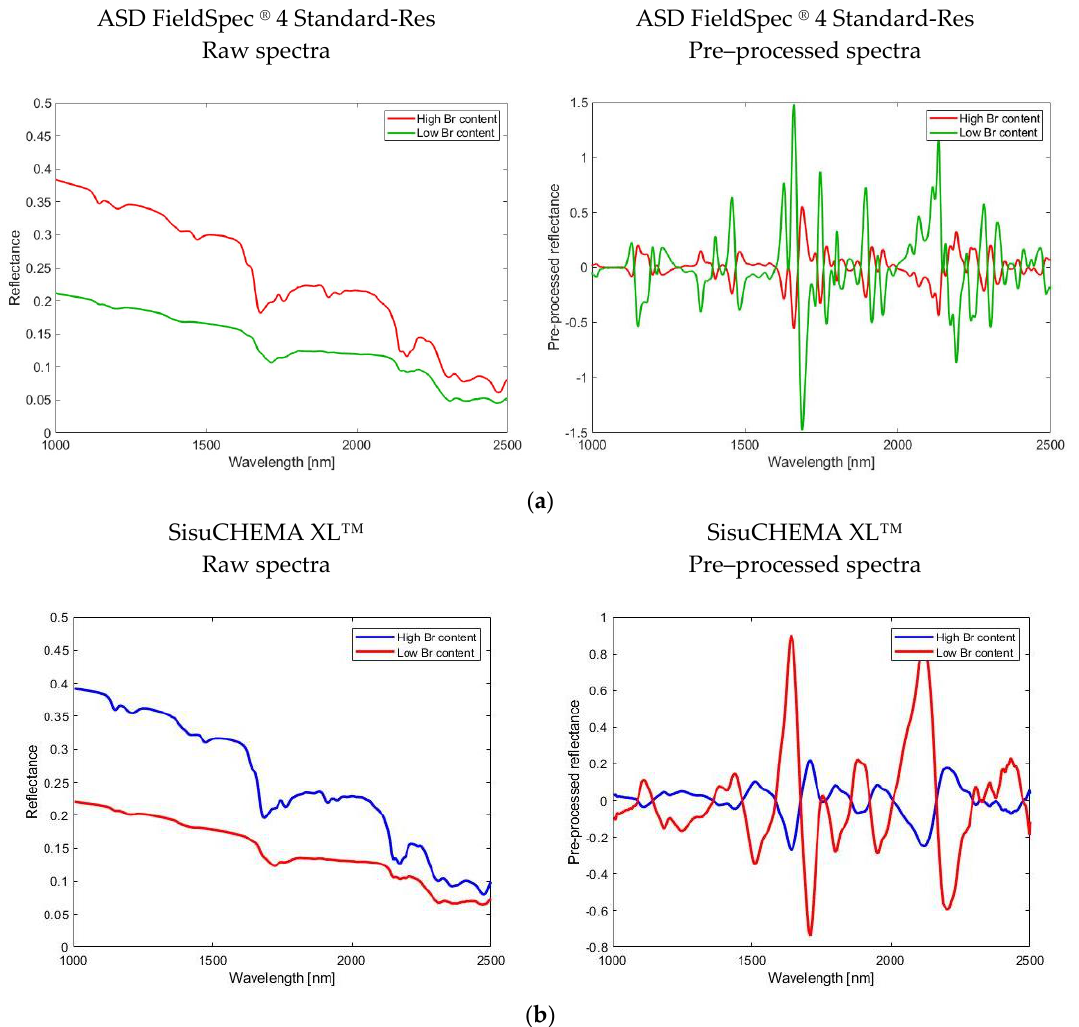
Figure 6. Raw and preprocessed reflectance spectra (1000–2500 nm) averaged according to the two groups of samples characterized by high and low bromine content, collected by ASD FieldSpec ® 4 Standard-Res ( a ) and extracted from ROIs investigated by the SisuCHEMA XL™ ( b ).